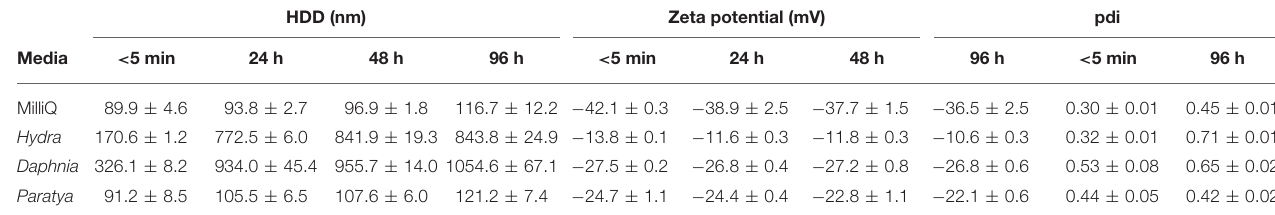
TABLE 1 | Effect of exposure time on HDD and zeta potential of